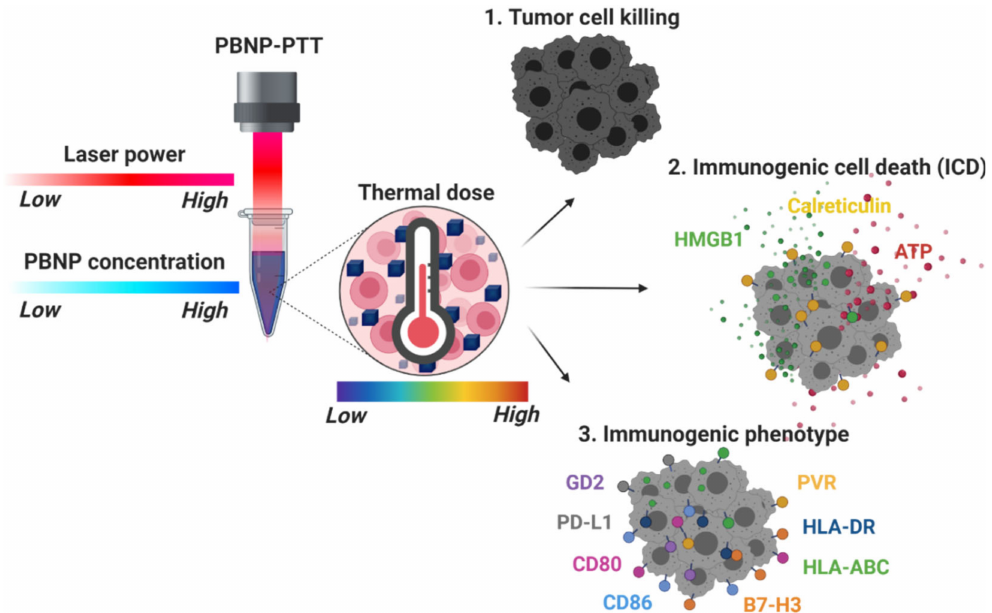
Figure 1. Schematic of the study. The thermal dose generated by PBNP-PTT was controlled by varying the PBNP concentration and near infrared laser power, independently. Subsequently, tumor cell death, immunogenic cell death (ICD), and cell surface markers associated with immunogenicity were measured on neuroblastoma cells as a function of PBNP-PTT-administered thermal